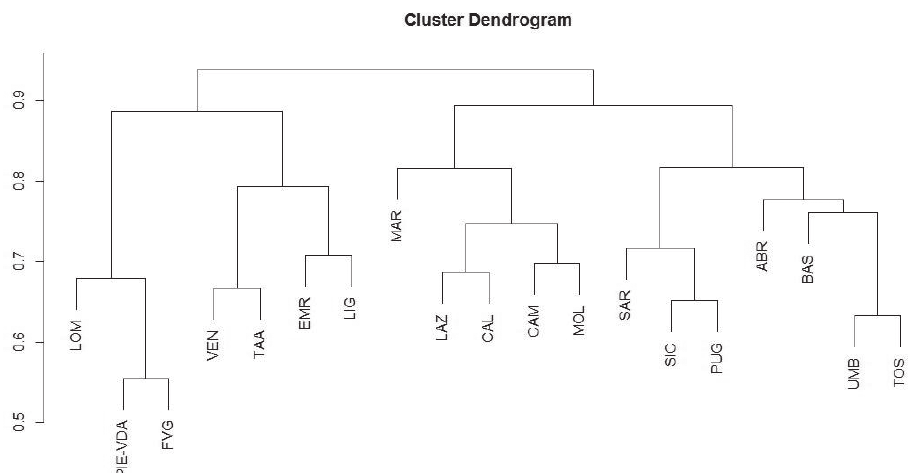
Figure 8. Hierarchical cluster analysis dendrogram of species on a Regional basis.